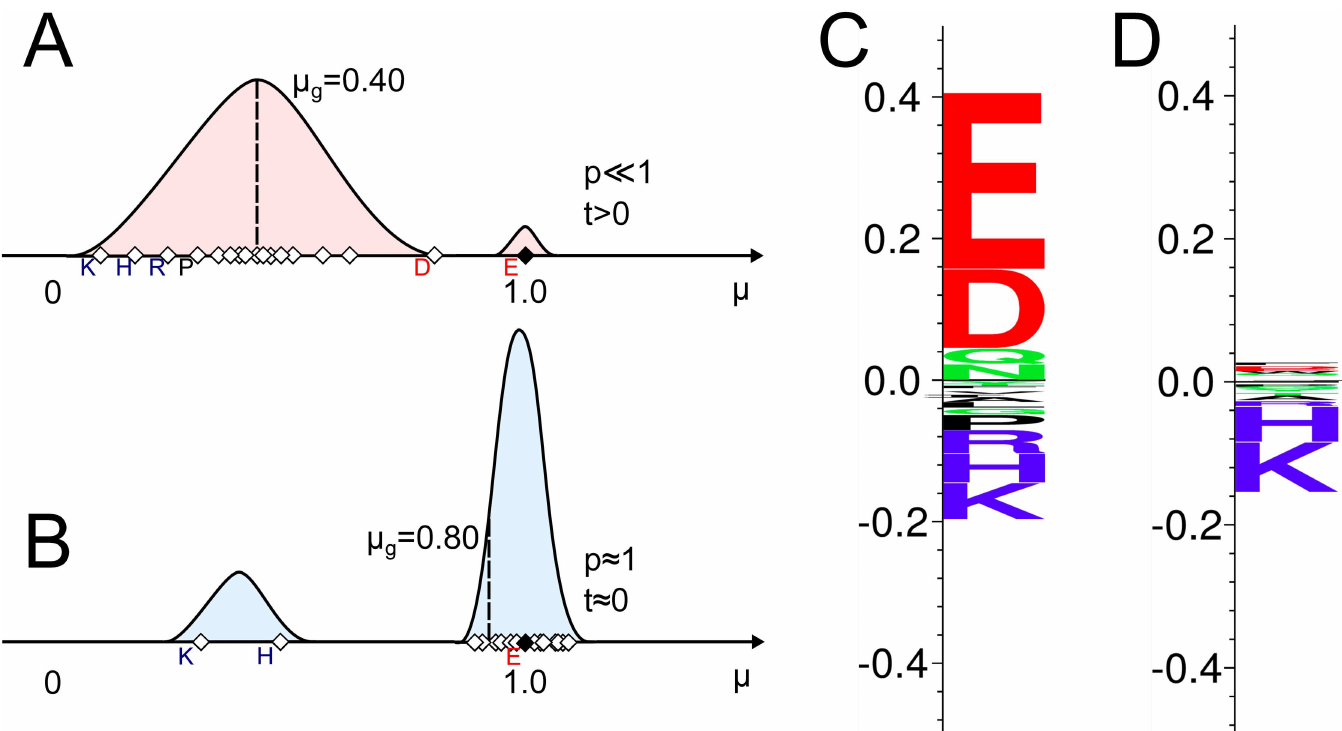
Fig 2. Schematic example of the generation of selectivity logo-plots. Figure showingexampleof selectivity of two epitopepositionsin overlapping peptides upon substitutions with all 19 amino acids. A and B shows illustrative density plots of substitutionvalues taken from a substitutionmatrix, with the mean substitutionvalue,. μ i , of each replacingamino acid shown in diamondshapes. Filled diamondis the native amino acid (E in both examples). C and D show the resultinglogo-plotof the positions exemplified in A and B, respectively. The logo-plotsare made using